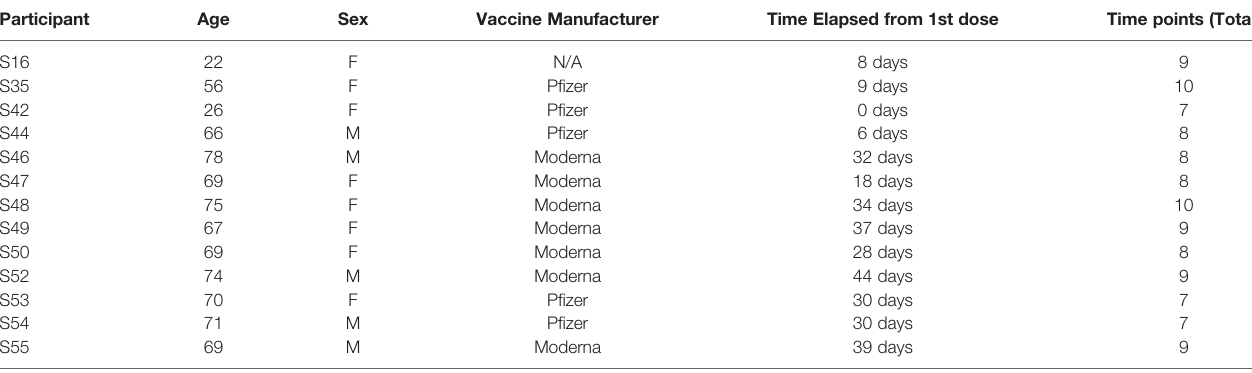
TABLE 2 | Summary of total oral mucosal fl uid collections from the vaccinated participants of the study.